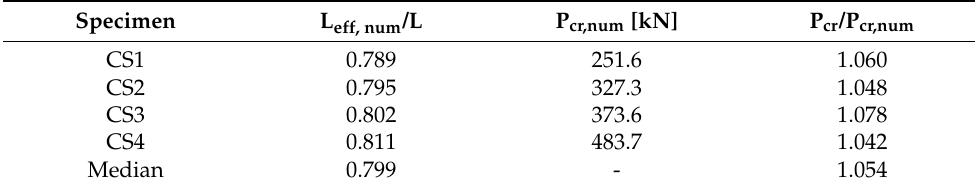
Table 5. Comparison of numerical and experimental results for the effective buckling length and buckling force.